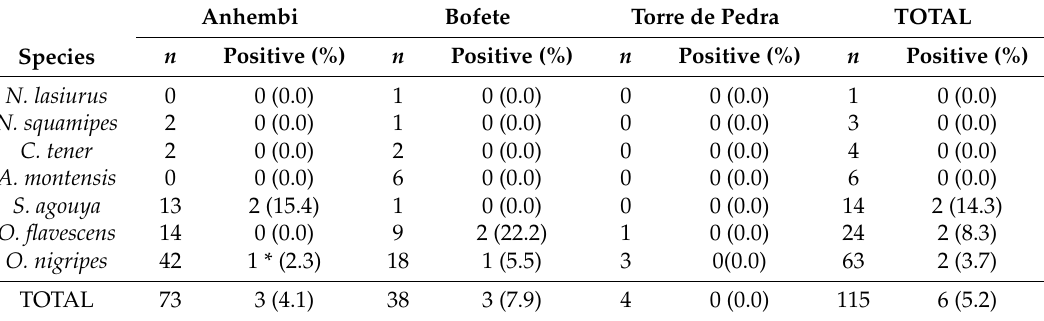
Table 2. Distributions of wild rodent fecal samples according to municipality and VACV positivity in Brazil. Anhembi Bofete Torre de Species